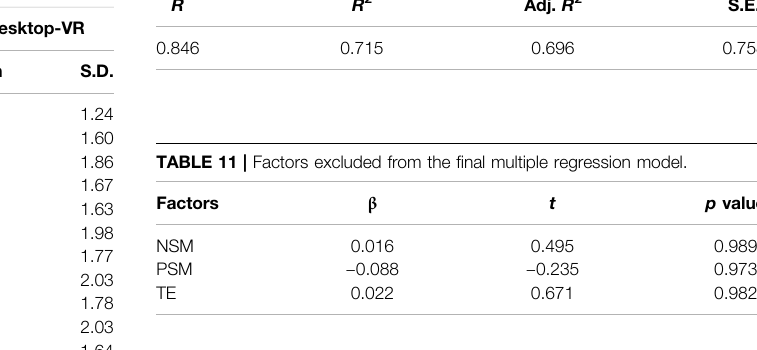
TABLE 9 | Results from the post-experience questionnaires (All constructs have values from 0 (lowest) to 10 (highest)).